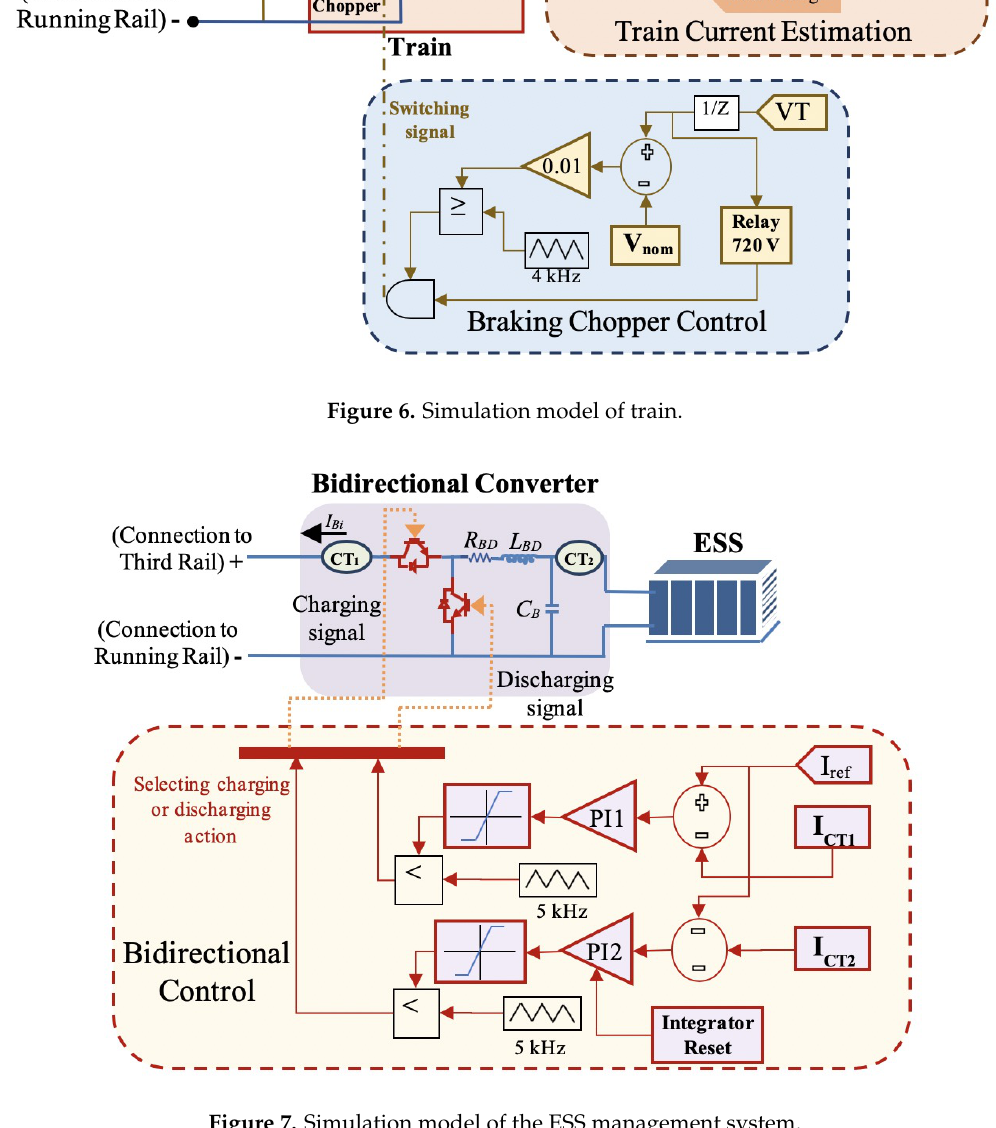
Figure 7. Simulation model of the ESS management